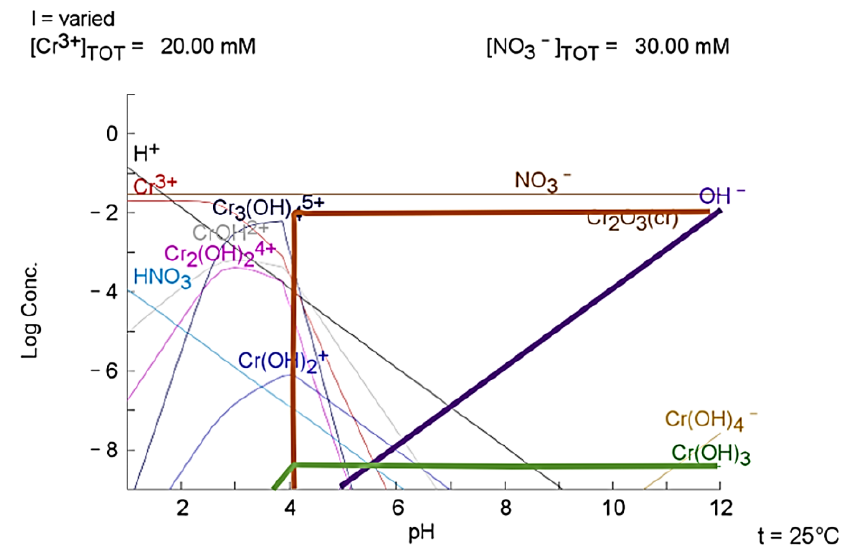
Figure 8. Simulated plots of the aqueous chemistry in 0.02 M Cr(NO 3 ) 3 solution at room tempera- ture.